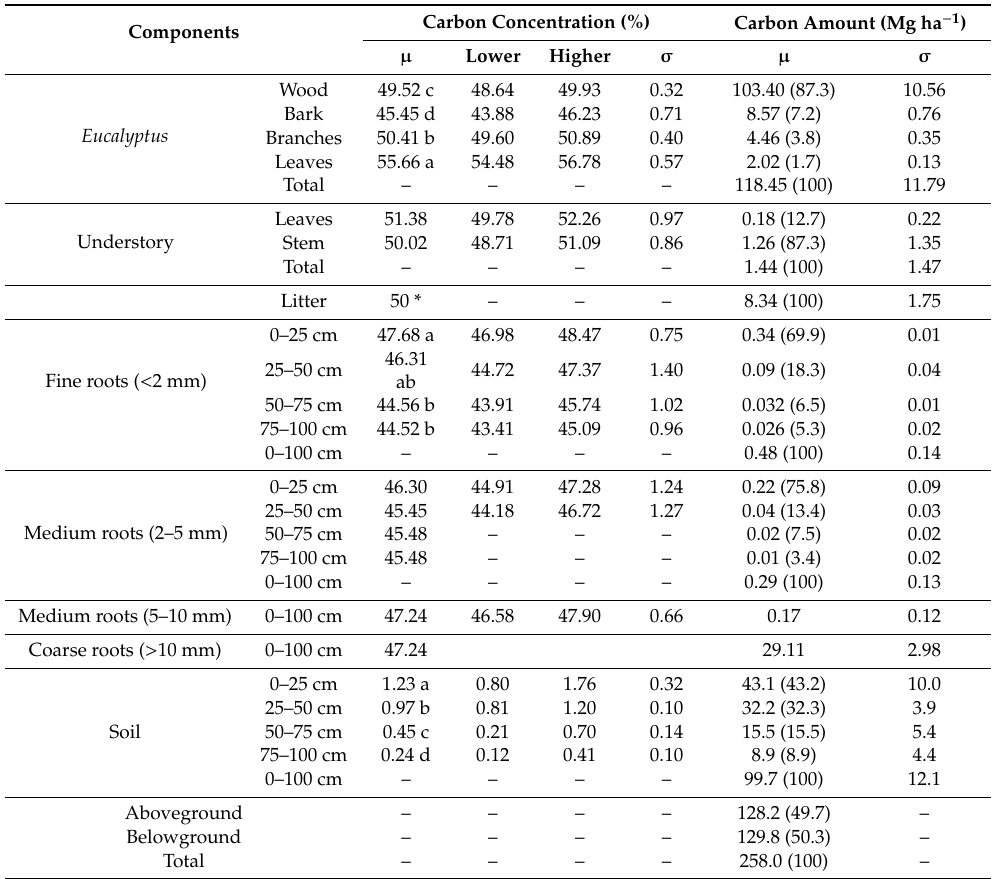
Table 4. Soil, above and belowground carbon concentration, and stock in the 10-year-old Eucalyptus urophylla × Eucalyptus globulus stand. µ = average (proportion of components between brackets). σ = standard deviation. In rows, di ff erent letters indicate significant di ff erences for the components ( Eucalyptus ) and depths (fine roots and soil) at p < 0.05 by Duncan’s test. * For litter, a carbon concentration of 50% was